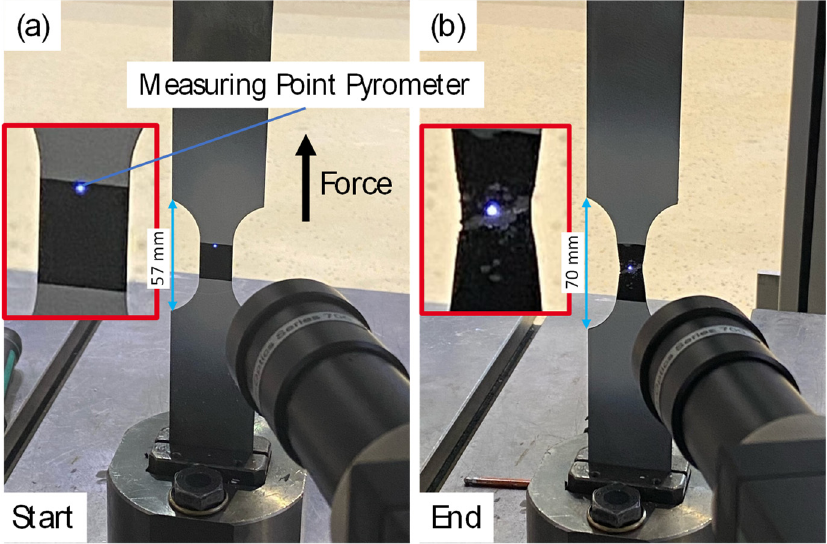
Figure 3. Experimental setup of temperature measurement with a pyrometer. ( a ) before the test and ( b ) after the test.